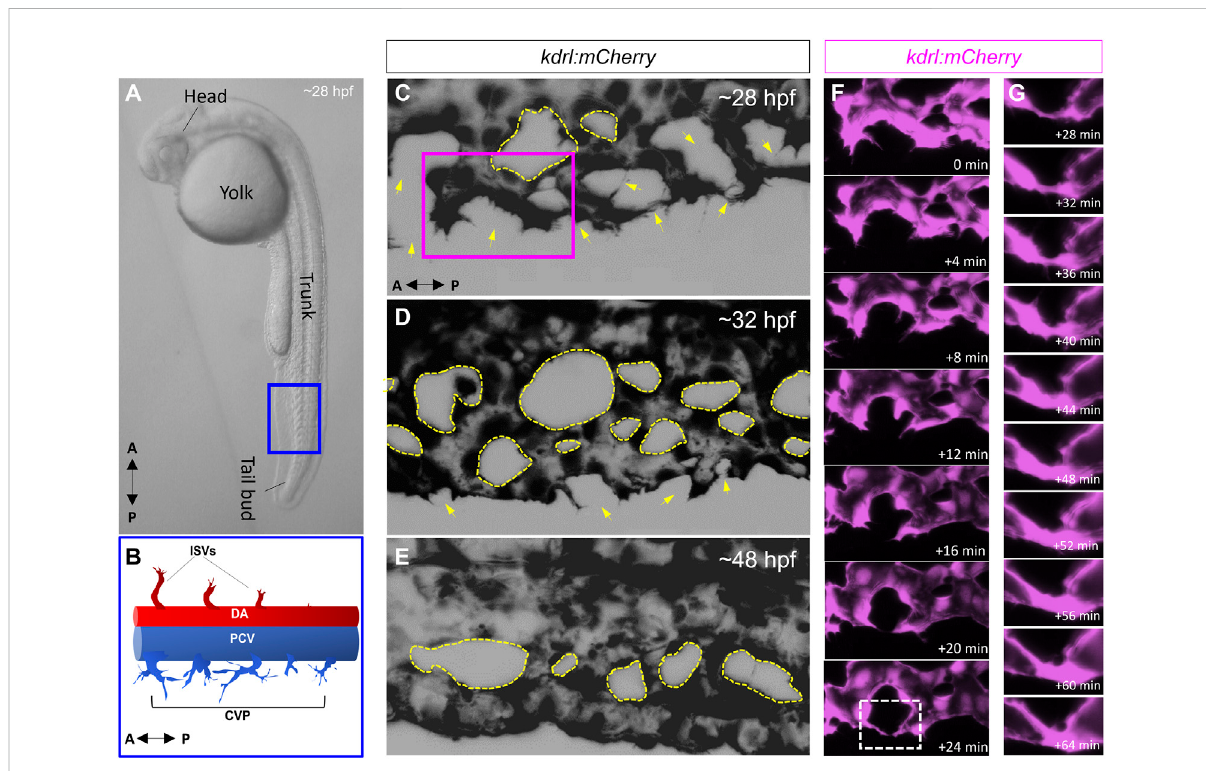
FIGURE 2 The zebra fi sh caudal vein plexus (CVP) is formed via BMP mediated angiogenesis. (A) Representative photomicrograph of a 28-h post fertilization (hpf) zebra fi sh embryo. Lateral view is shown. (B) Schematic depiction of the two conserved axial vessels in the blue boxed region in A, depicting the dorsal artery (DA) and posterior caudal vein (PCV). The arterial-fated intersegmental vessels (ISVs) emanate from the dorsal surfaces of DA andmigrate dorsallyinresponse to Vegfgradients.ThePCV givesrise to venoussprouts thatmigrateventrallyinresponse to Bmpgradients toformthecaudalveinplexus(CVP). (C – E) RepresentativemaximumprojectionsoftheCVPduringsuccessivestagesofsprouting,anastomosisand remodeling. The yellow arrows in (C) and (D) point to putative sites of tip cell fusion or anastomosis (F) Higher magni fi cation of the purple boxed region in C, showing fusion of ipsilateral tip cells (G) Digital zoom of the white boxed region in F, showing progressive lumenization of site of